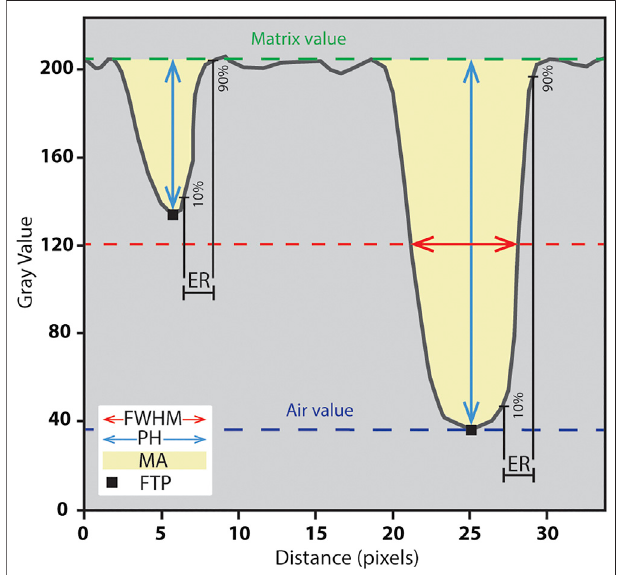
FIGURE2| 1Dhypothetical grayvaluepro fi le acrosstwoopen fractures of different widths showing the parameters measured in our approach: full- width-half-maximum (FWHM), peak height (PH), missing attenuation (MA), and edge response (ER). Red dotted lines indicate the FWHM level, which is set at a gray value halfway between air and matrix values (blue and green dotted lines, respectively). Note that FWHM cannot be determined for fractures with gray values above the FWHM